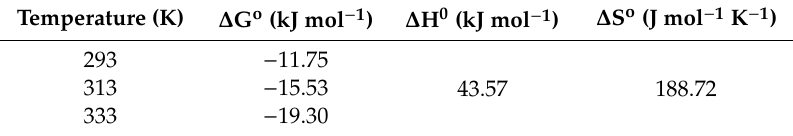
Table 3. Thermodynamic parameters for U(VI) entrapment onto PVKAP.